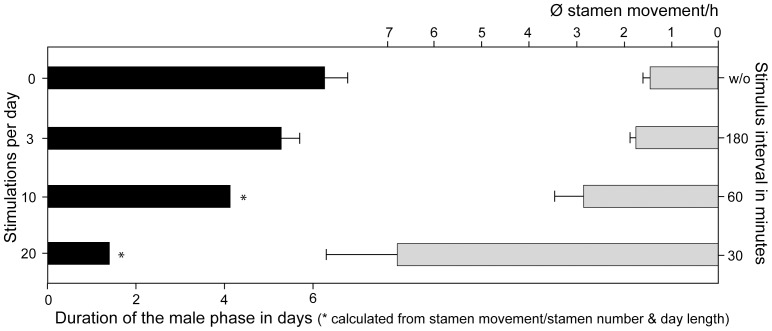
Influence of different visitation rates (stimulus intervals) on the stamen movement rate and the corresponding lenght of the staminate phase in Nasa macrothyrsa.